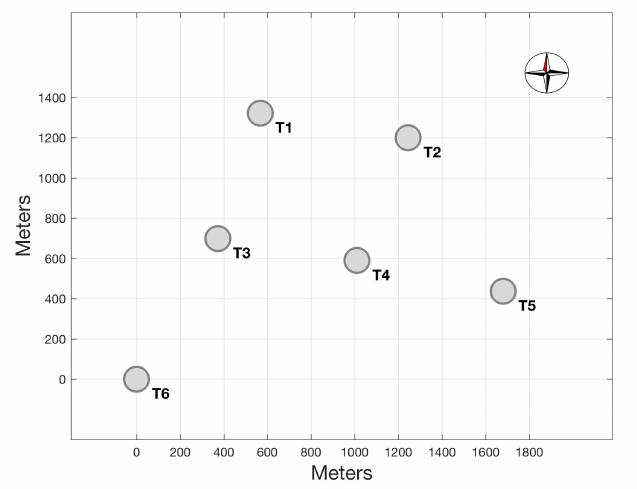
Figure 1. The layout of the test case 1 wind